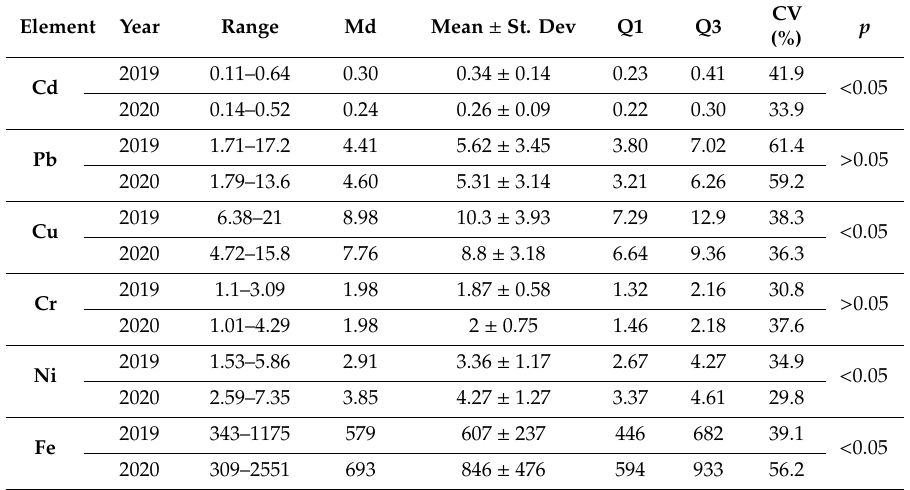
Table 1. Descriptive statistics of results for moss samples collected in 2019 and 2020 (in mg / kg dry weight